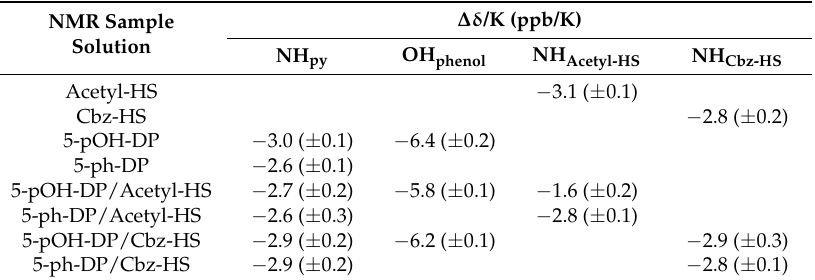
Table 2. Temperature coefficients of NMR solution of dipyrromethanes and HS-derivatives in their free form and in their